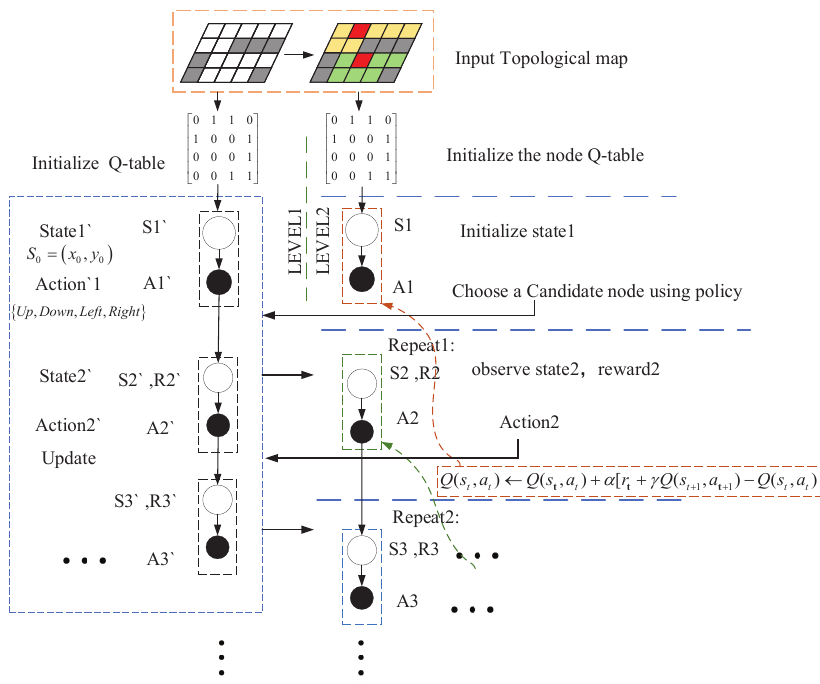
Figure 4. The framework of Multi-SARSA algorithm structurally improved, in which the left column is the first layer and the right column is the second layer, and the a priori information is provided by the topological